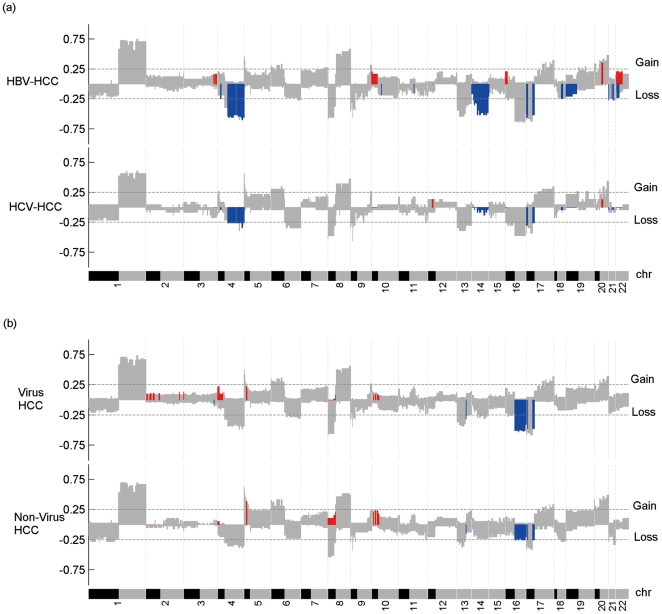
Profiles of etiology-related chromosomal aberrations in HCCs.
(a). the comparison of chromosomal aberration profiles between HBV-related HCCs and HCV-related HCCs. (b), the comparison of chromosomal aberration profiles between virus-related HCCs and non-virus-related HCCs. Copy number gains and losses with a significant difference in frequencies were highlighted in red and blue, respectively.